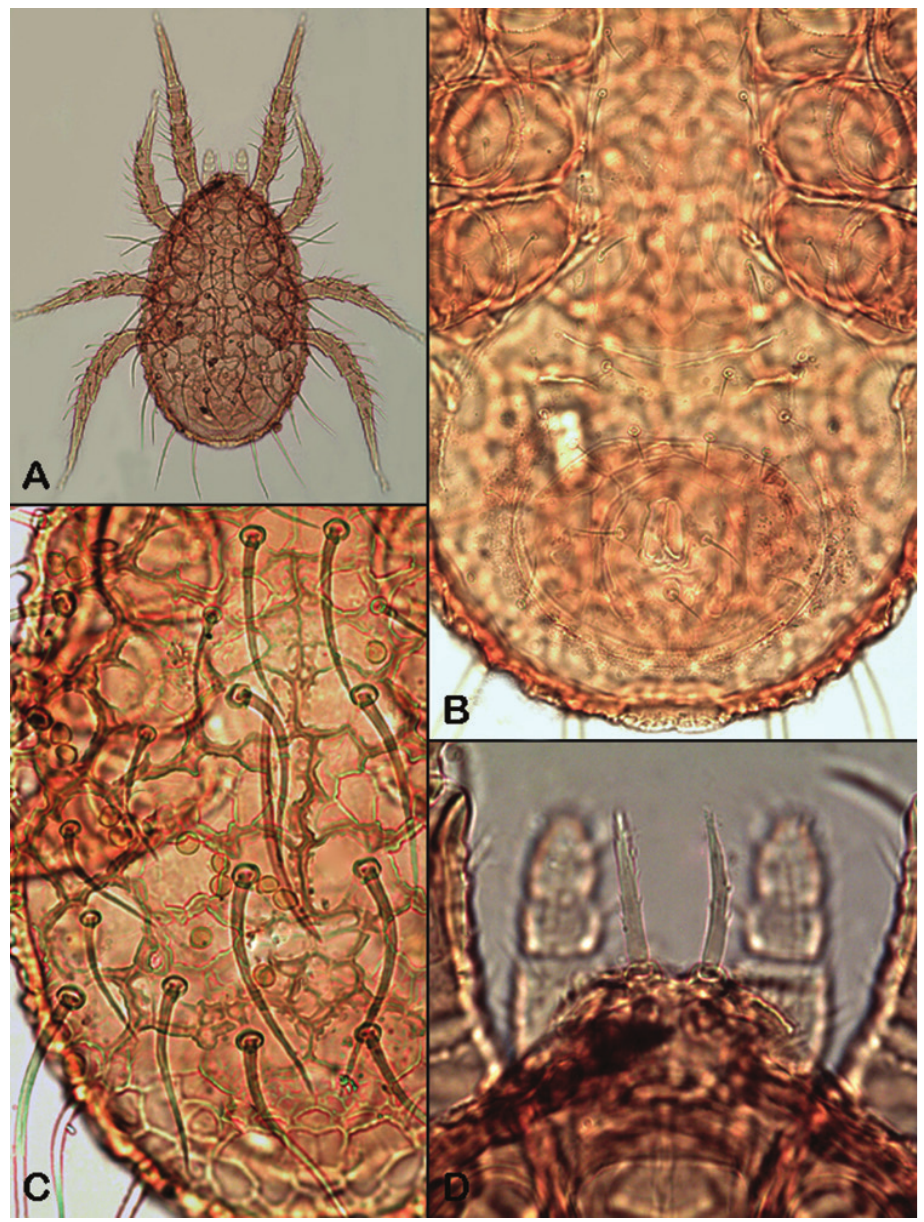
Plate 5. Ameroseius cavernosus , female. A Dorsal idiosoma with legs B Epigynal and anal shield C Dorsal shield sculpture, posterolateral view D Setae